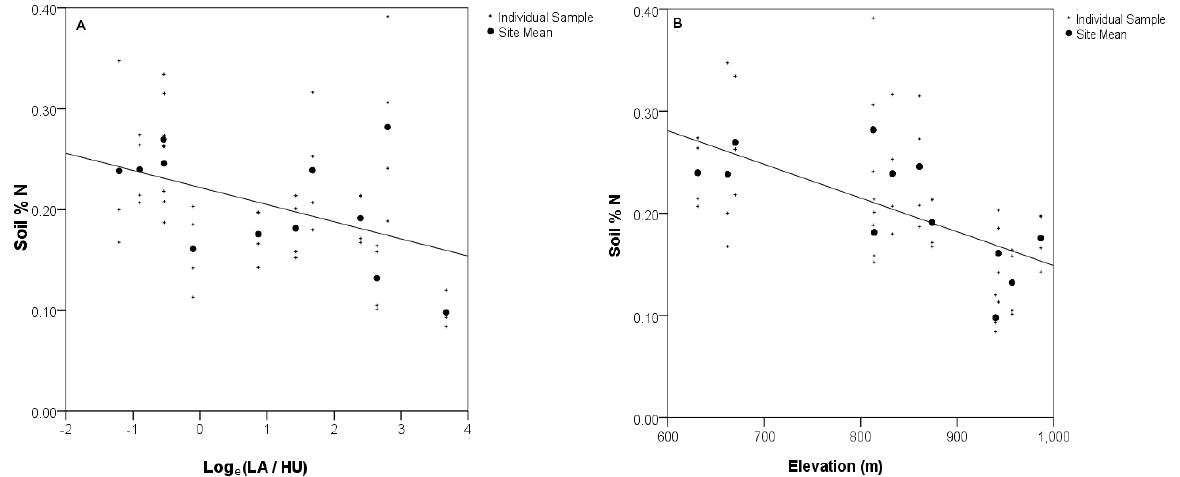
Figure 2. Soil % N. Mean soil N concentration in the 12 study sites versus mean log acres per housing unit (LA/HU) in the surrounding landscape. Note that higher values of housing density occur at the left of the diagram, at lower values of (LA/HU). 1 land acre per housing unit = 0.4 ha per housing unit. ( a ) Where surrounding housing densities were greater, mean %N in soils of protected areas tended to be greater ( R 2 = 0.27); ( b ) Site elevation was also a strong predictor of soil %N ( R 2 = 0.52, p < 0.01) across the twelve study